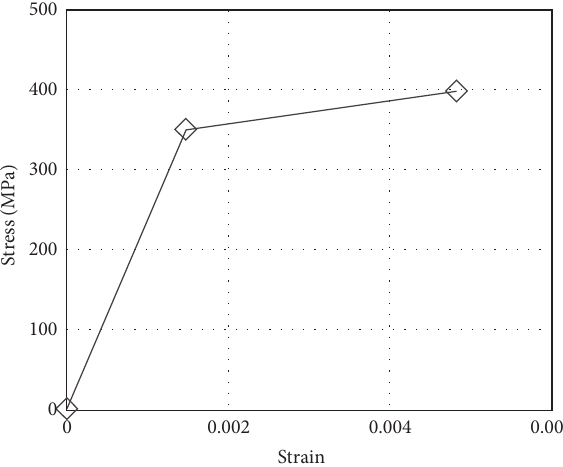
Figure 8: Stress-strain curve of tower 1